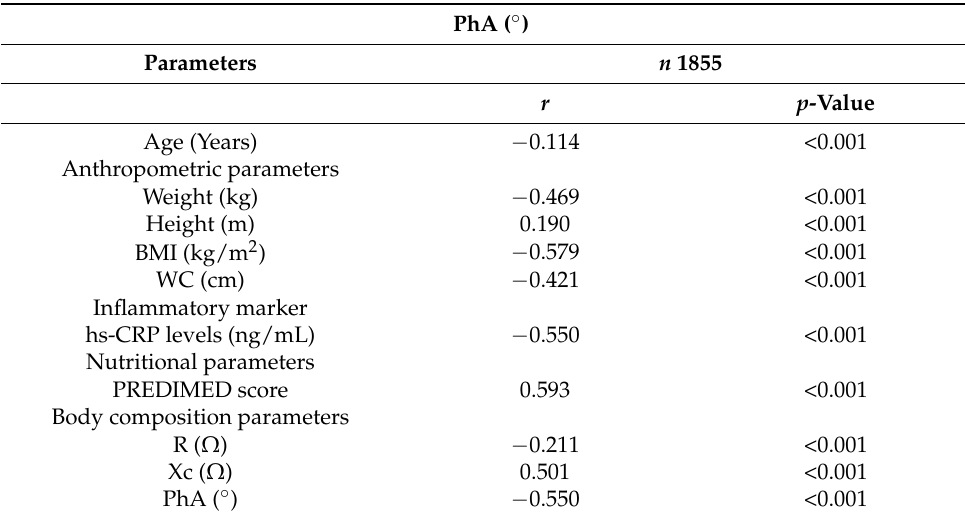
Table 3. Correlations between PhA and age, anthropometric parameters, inflammatory marker, nutritional and BIA